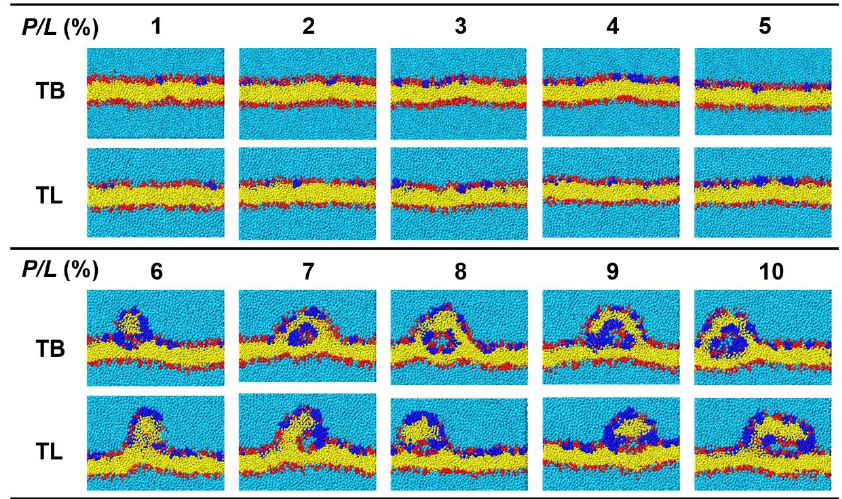
Figure 6. Cross-sectional snapshots of lipid bilayer bound by TBs and TLs at a variety of peptide concentrations. Blue, red, yellow, and light blue beads represent peptides, lipid head groups, lipid tails and water, respectively.